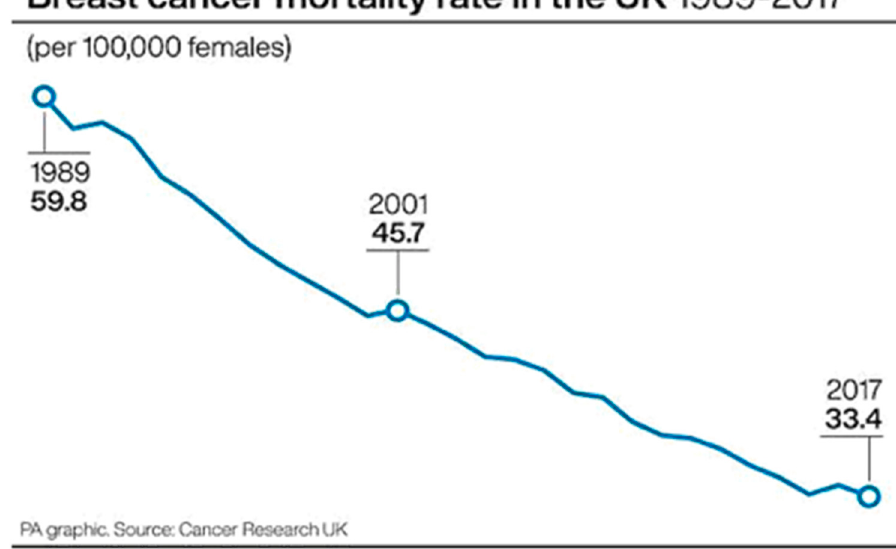
Figure 1. Mortality rate of breast cancer among females in the UK between 1989 and 2017.